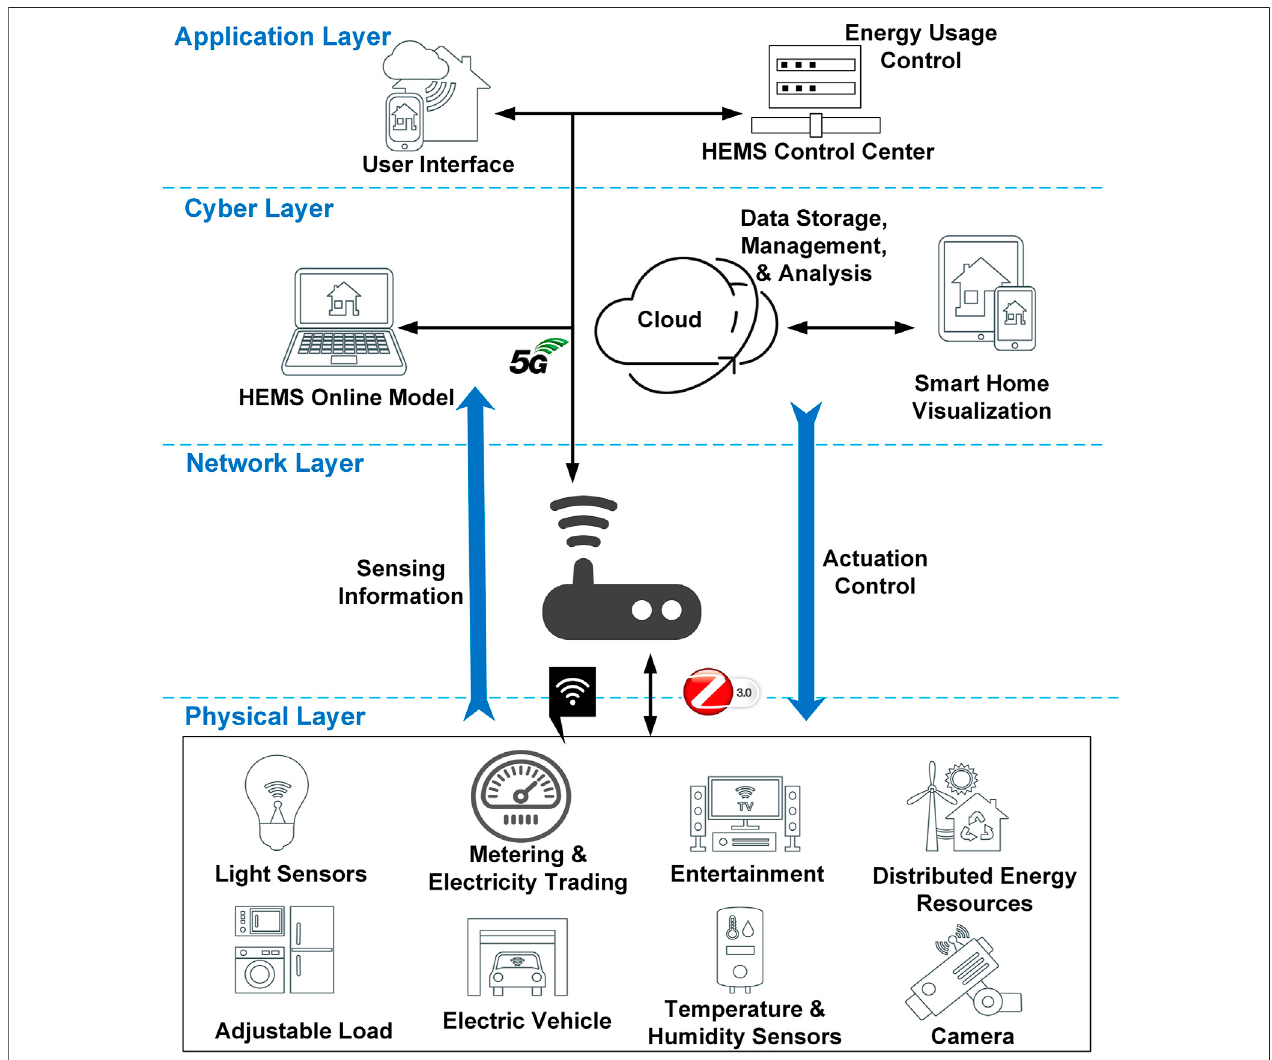
FIGURE 6 | Architecture of an intelligent home energy management